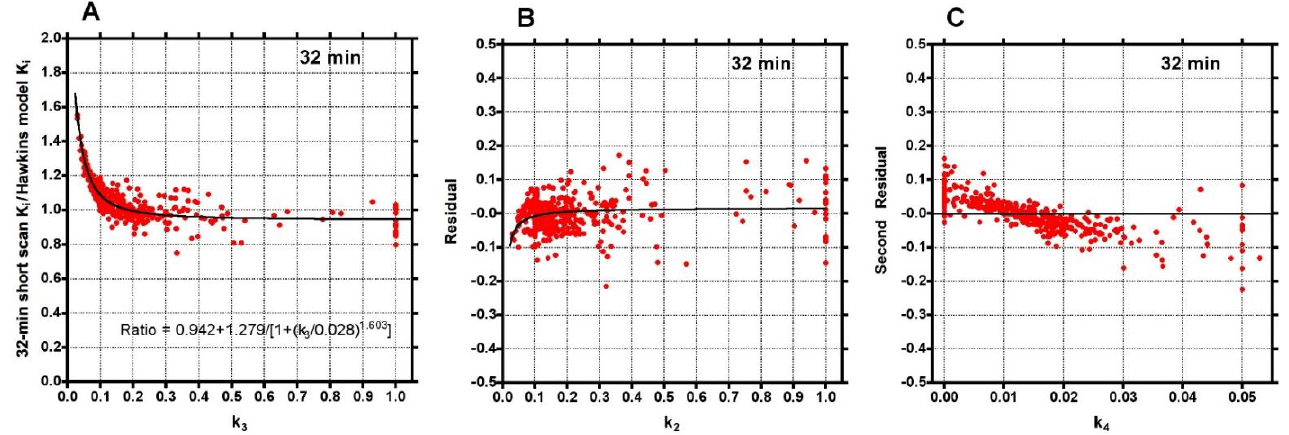
Figure 3. ( A ) Ratios of the 32-min short-scan K i values to the 60-min Hawkins model values shown in Figure 2 plotted against the Hawkins model k 3 values. The continuous black line is the least-squares fit to the 378 data points. ( B ) Residuals from the curve fit in ( A ) plotted against the Hawkins model k 2 values. The continuous black line is the least-squares fit to the data points. ( C ) Residuals from the curve fit in ( B ) plotted against the Hawkins model k 4 values.